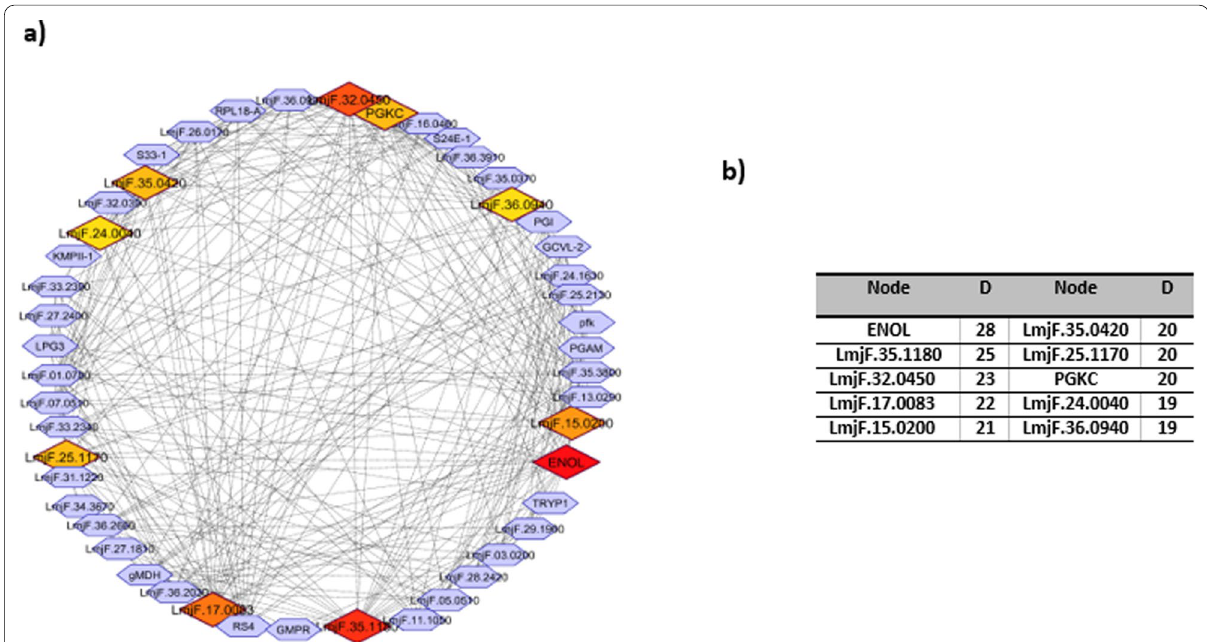
Fig. 4 Whole Connected Component of the PPI Network of differential expressed proteins that were visualized by Cytoscape software. a The nodes are layout by degree value (darker to bright brown nodes corresponded to hub proteins). b The hub proteins along with their degree ( D